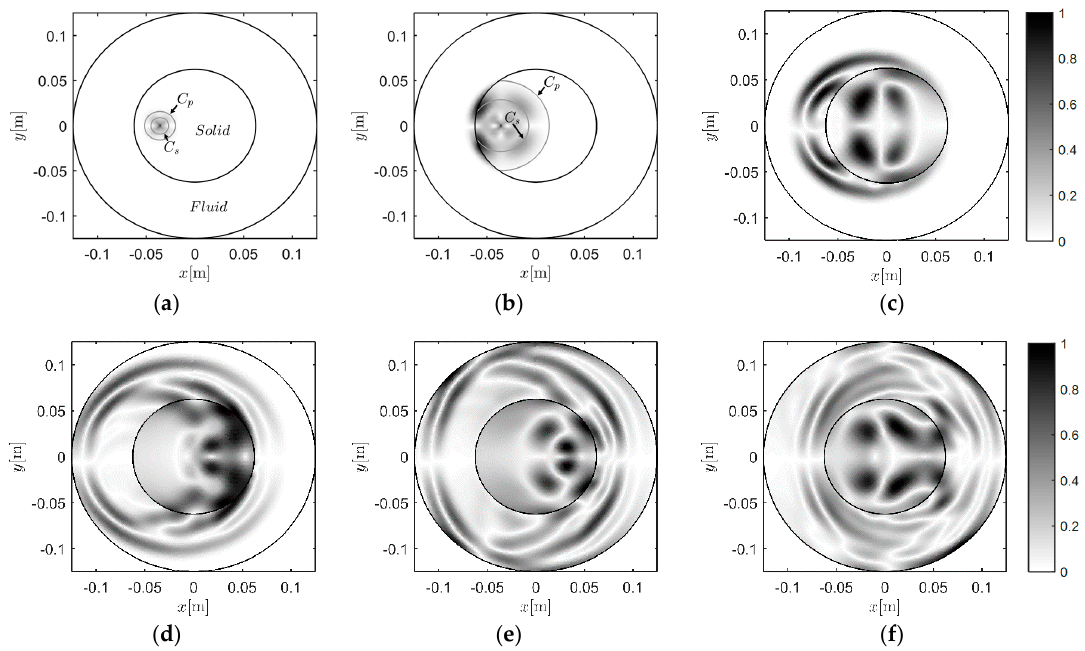
Figure 9. Snapshots of the wavefield induced by the source at − 0.0360 m, and 0 m: ( a ) 20 μ s, ( b ) 25 μ s, ( c ) 35 μ s, ( d ) 45 μ s, ( e ) 55 μ s, and ( f ) 65 μ s.